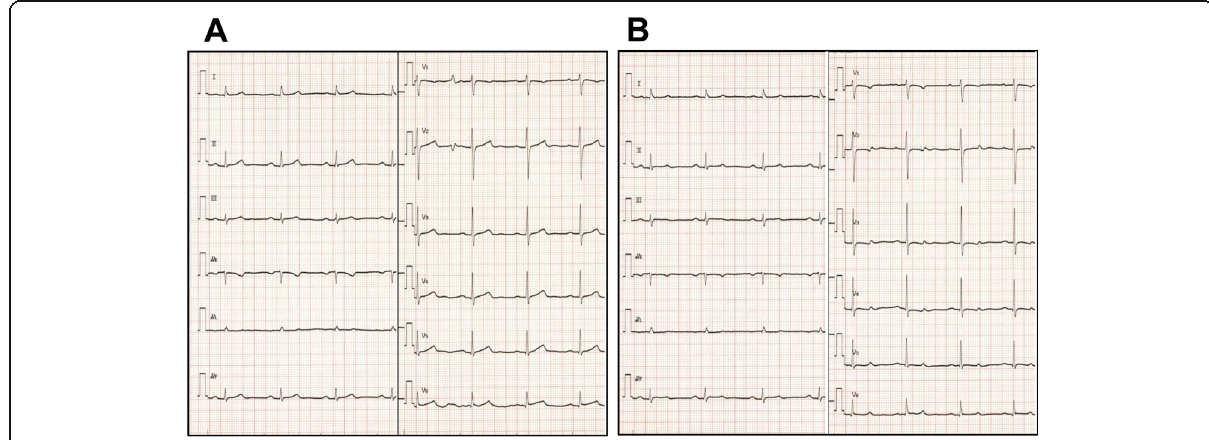
Fig. 1 Electrocardiograms (ECGs) recorded on bedside. The patient complained of angina after sleep (10 PM) and midnight (1 AM) on day 2 as well as day 1 of S1 chemotherapy. Bedside ECGs were incapable of capturing abnormal findings although they were conducted immediately after the attacks. a After sleep. b